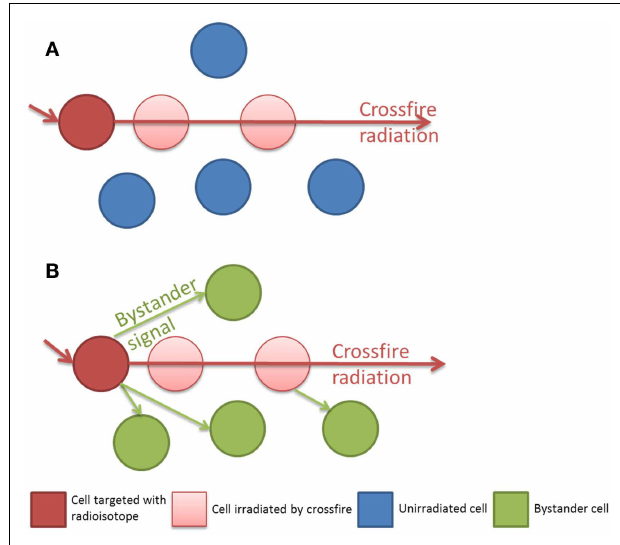
FIGURE 1 | (A) Isolated radiation crossfire model, the biological effect to un-irradiated cells is related to the path length of the radionuclide. (B) Bystander and crossfire model, additional non-targeted cells receive a biological effect from Bystander